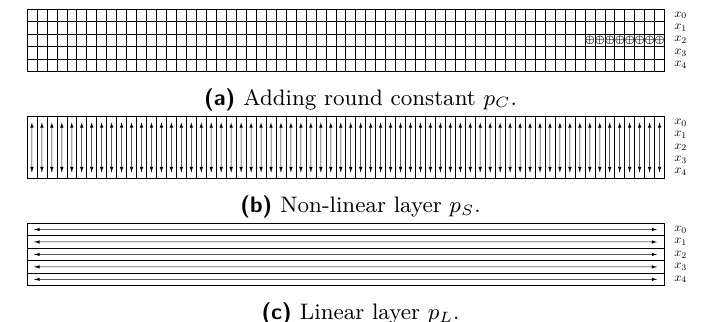
Figure 2: Ascon ’s round function p